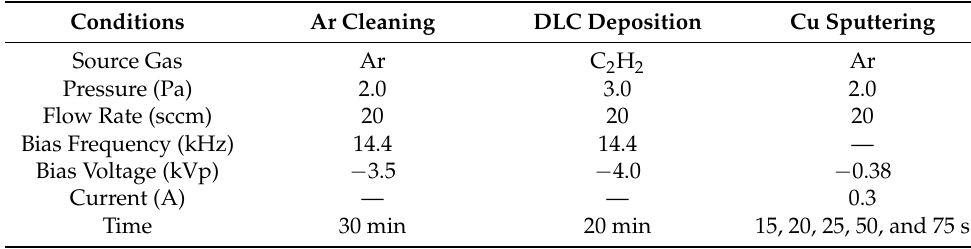
Table 1. Conditions of cleaning, deposition, and